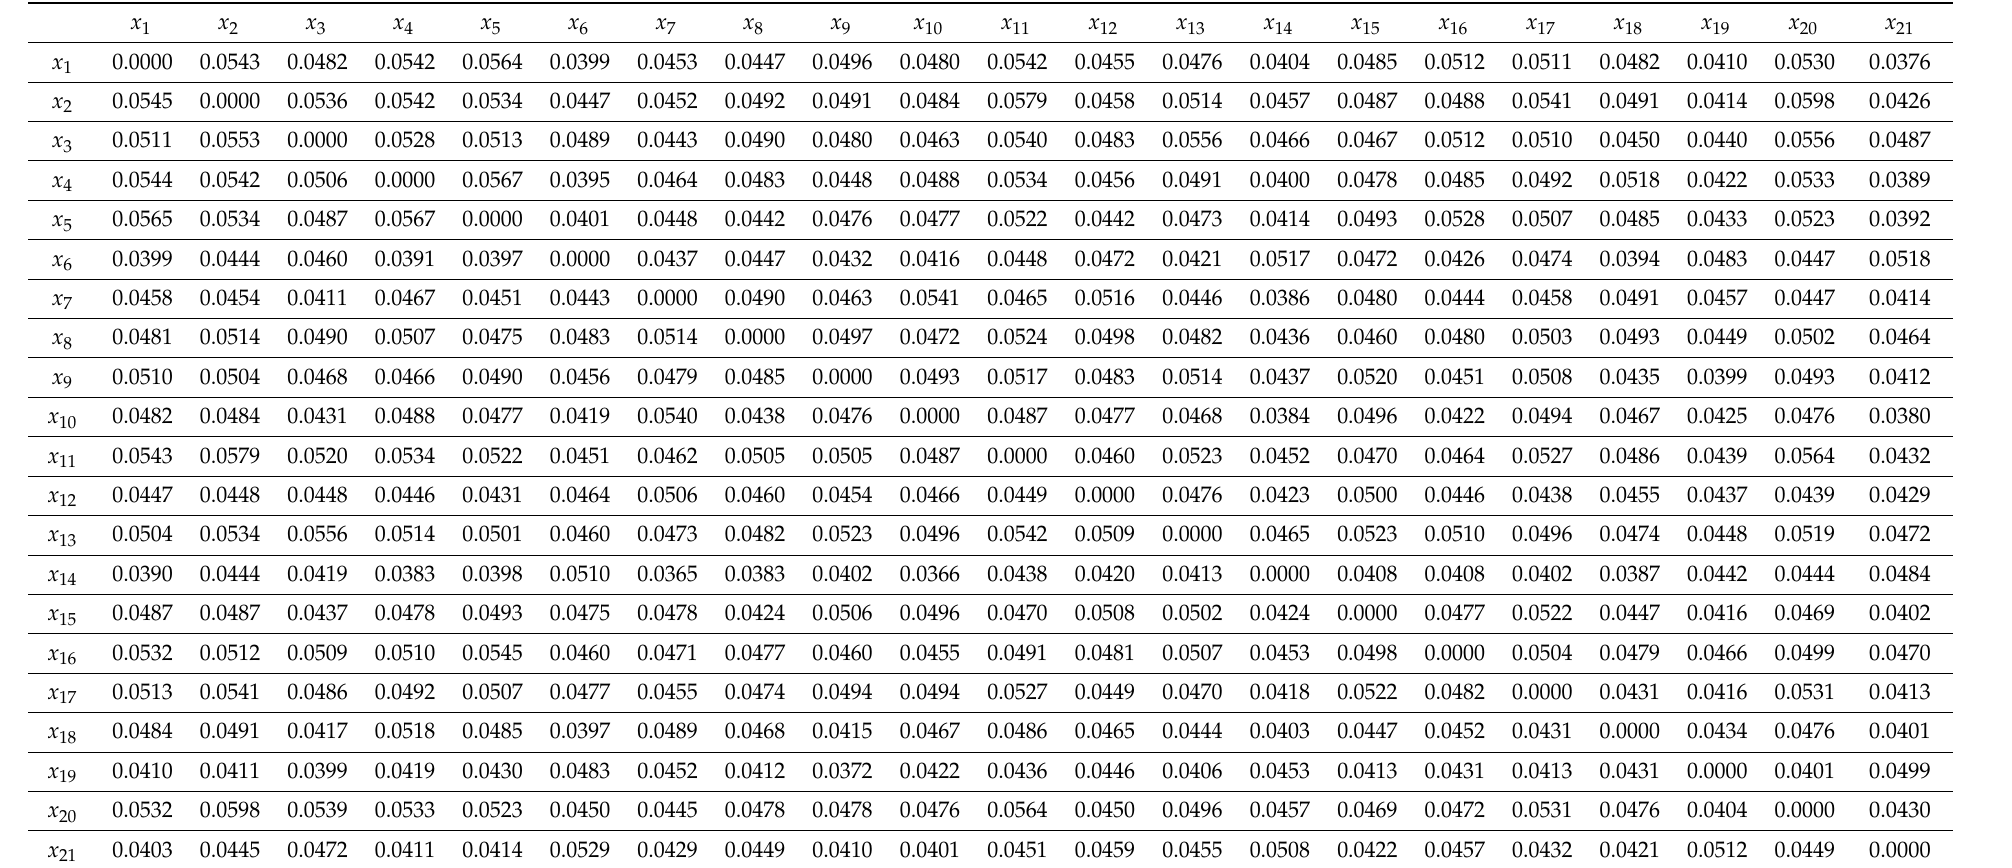
Table A3. The normalized direct influence